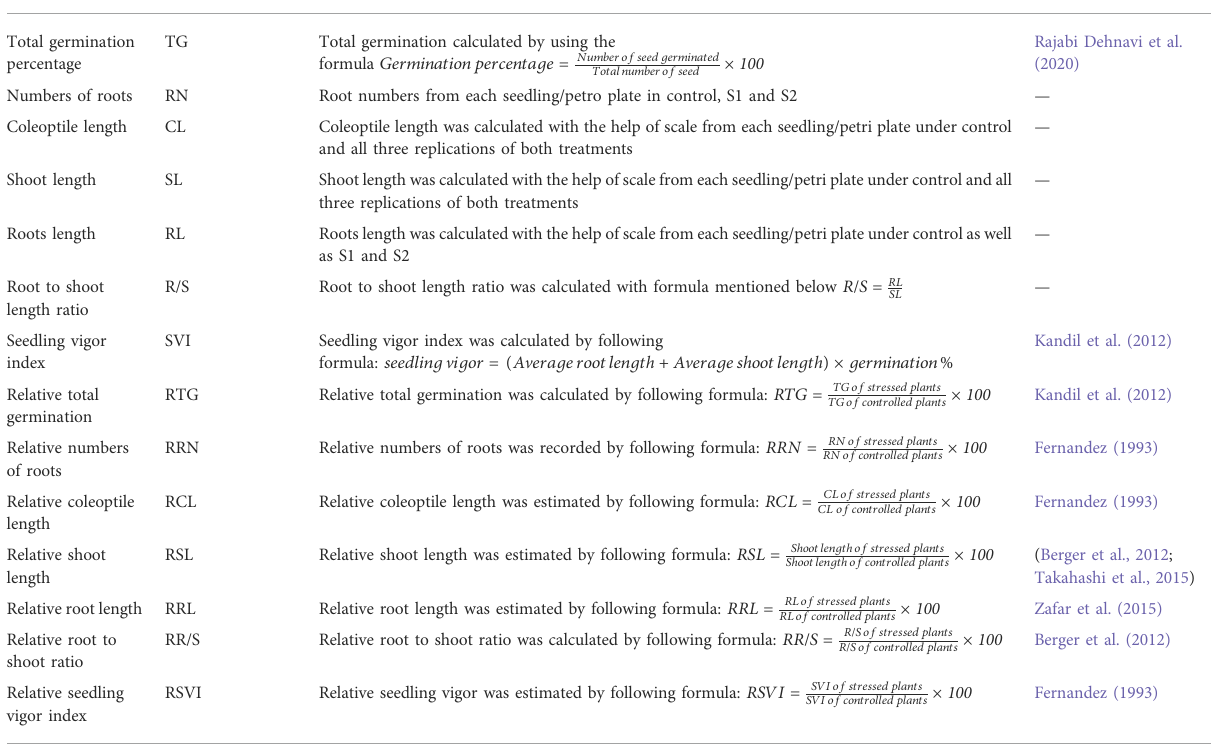
TABLE 1 Parameters measured to assess salinity